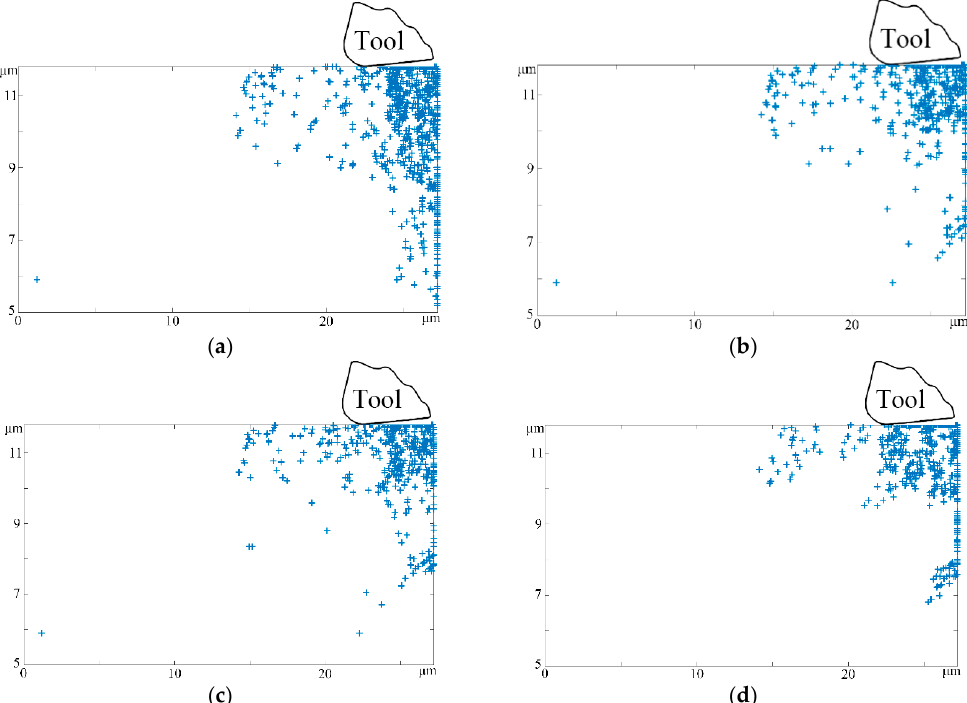
Figure 5. The subsurface defects microstructural evolution with different clearance angles (cutting distance 5 µ m, cutting speed 10 m/s, cutting depth 1 µ m, tool edge radius 0.25 µ m, and rake angle 5 ◦ ). ( a ) clearance angle 0 ◦ ; ( b ) clearance angle 5 ◦ ; ( c ) clearance angle 8 ◦ ; ( d ) clearance angle 15 ◦